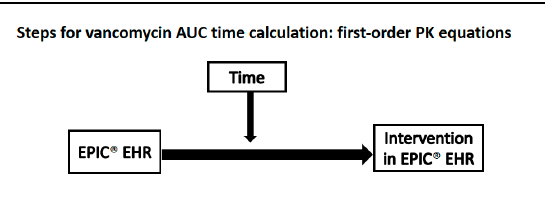
Figure 2. Procedure for vancomycin AUC time calculation using the first-order PK equations method.